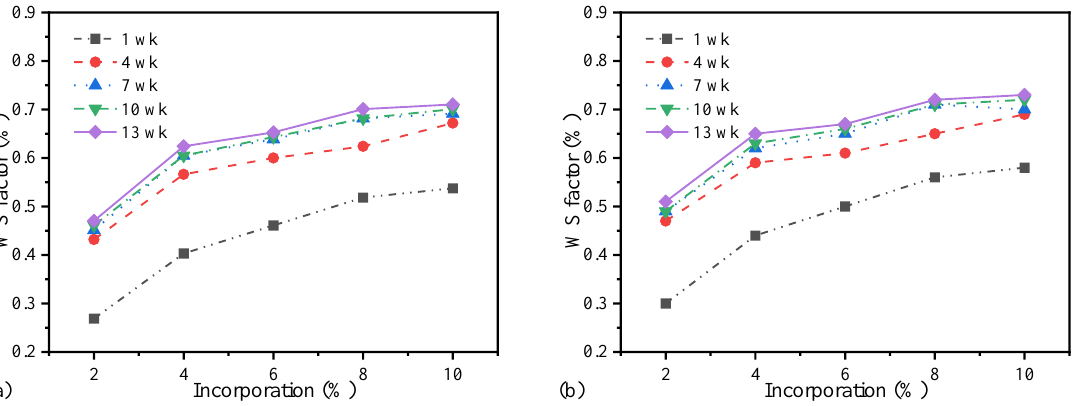
addition cannot make the curing agent act with high efficiency.